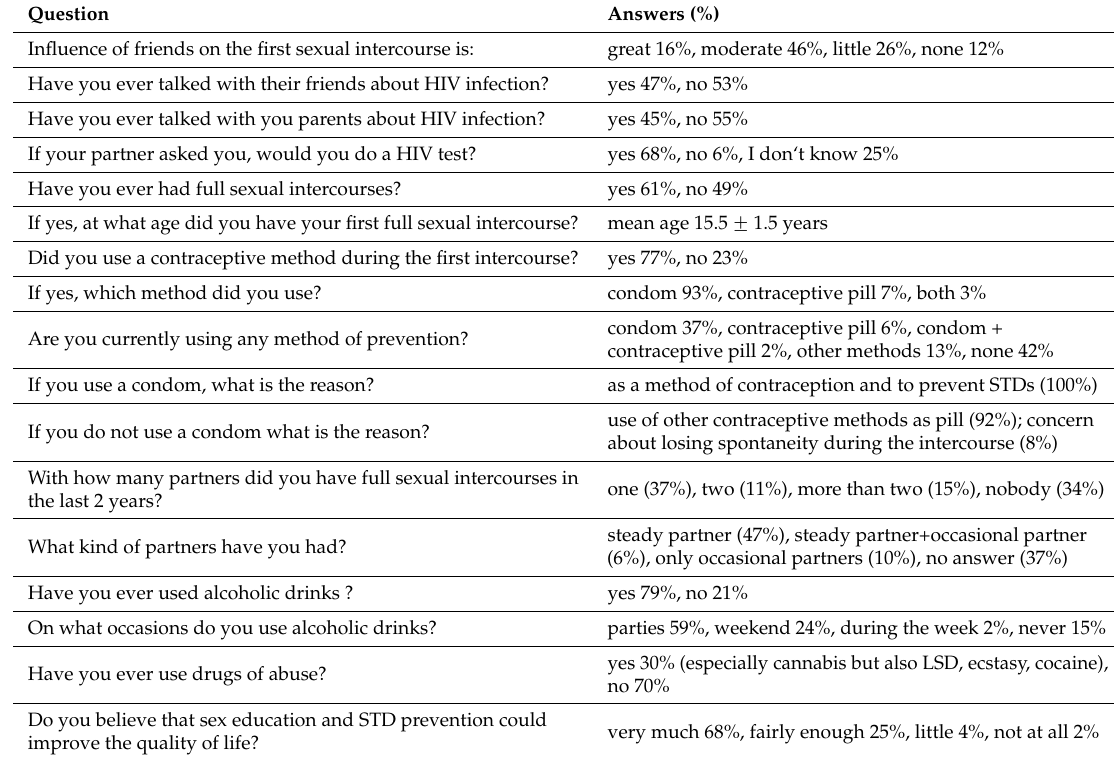
Table 3. Results of the third section of the